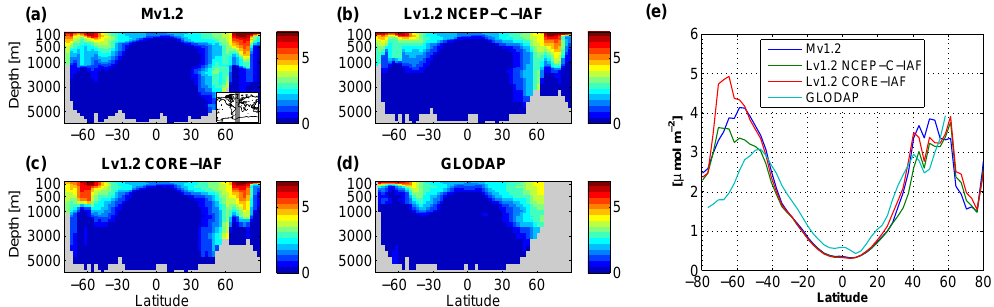
Figure 5. Zonal mean CFC-11 concentrations (nmolm − 3 ) along a section through the Atlantic/Southern Ocean (as indicated by the grey shaded area in panel a ) averaged over the years 1988 to 1998 for the model configurations (a) Mv1.2, (b) Lv1.2 forced with NECP-C-IAF, (c) Lv1.2 forced with CORE-IAF, and (d) CFC-11 concentration taken from the GLODAP gridded data set. Panel (e) displays the global zonal mean CFC-11 column content (µmolm − 2